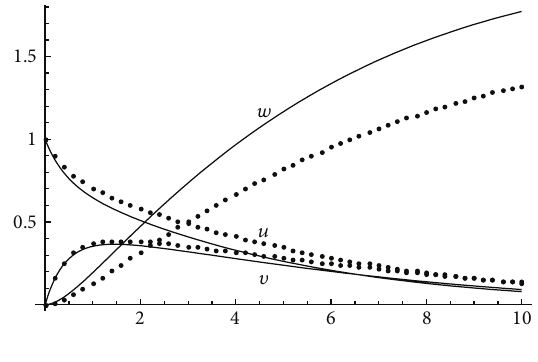
Figure 5: Profile of the normalized concentrations of the substrate 𝑢 , enzyme-substrate complex 𝑣 , and product 𝑤 for 𝑘 = 2 , 𝜆 = 1.0 , 3 and 𝜀 = 0.6 , 𝛼 1 = 0.95 , 𝛼 2 = 1.0 , and 𝛼 3 = 0.9 (solid line); 𝛼 1 = 𝛼 2 = = 1 (dotted line). 𝛼 3